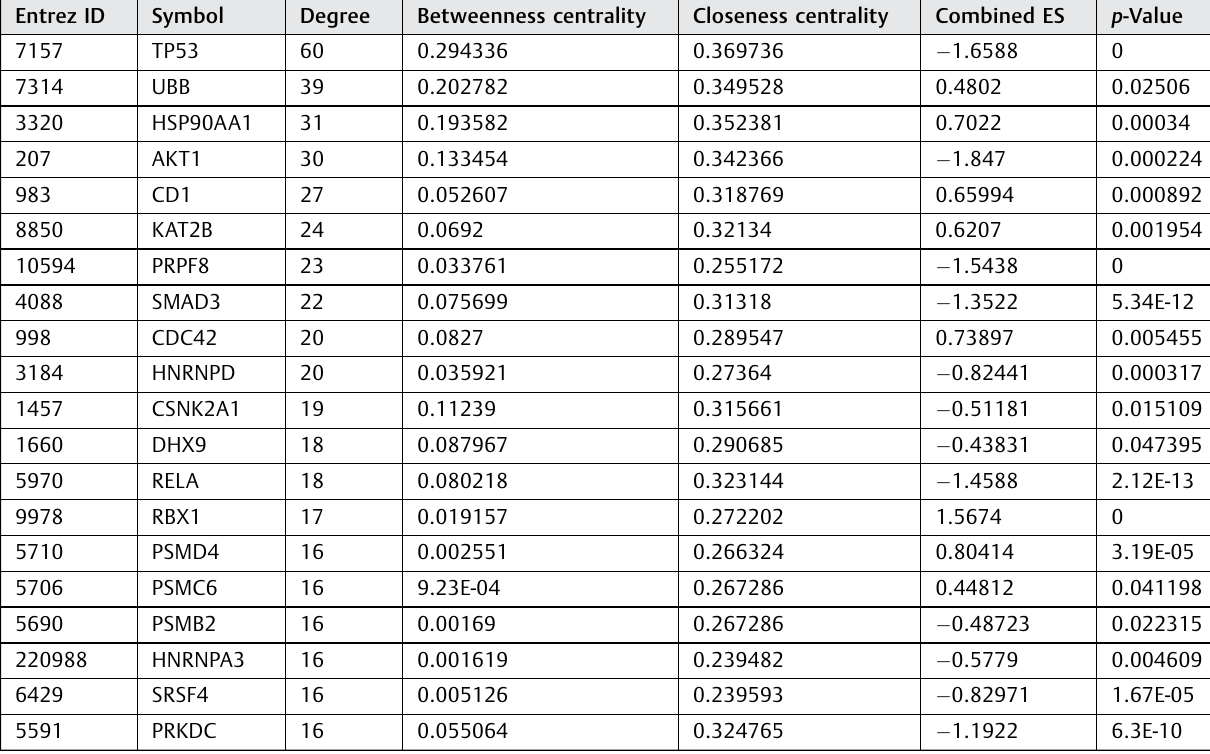
Table 2 Top twenty hub genes prioritized based on the topological parameters, that is, degree using